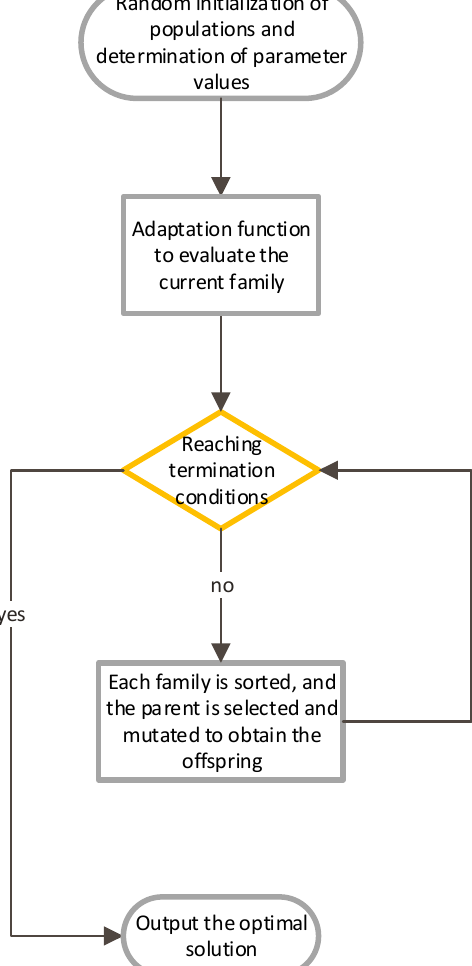
Figure 2. Flowchart of implementation process of LCA.